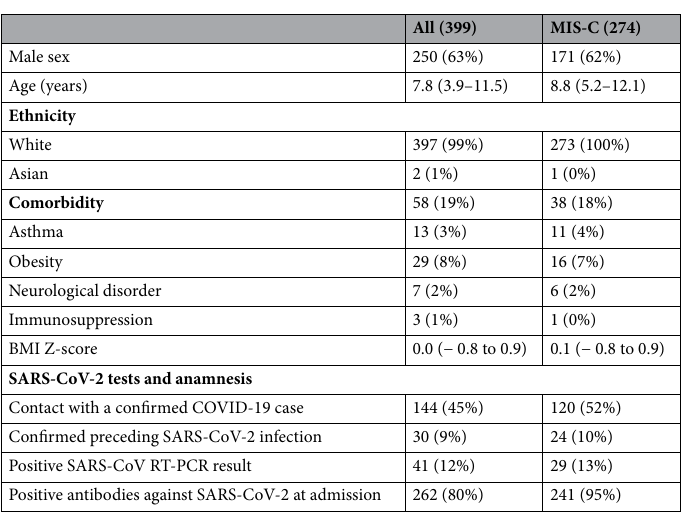
Table 1. Demographic characteristic and SARS-CoV-2 status of a studied group. Binary data given as count (per-cent), and numerical data as median (interquartile range). BMI body mass index, COVID-19 coronavirus disease 2019, RT-PCR real-time transcription polymerase chain reaction, SARS-CoV-2 severe acute respiratory syndrome coronavirus